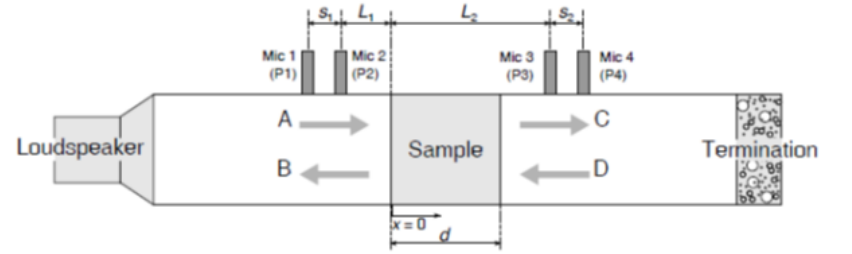
Figure 5. Schematic drawings of a four-microphones impedance tube. A represents the energy emitted by the loudspeaker, C is the component that crosses the sample, D is the component reflected by the termination, and B is the component reflected by the sample and/or that crosses the sample after being reflected by the termination.